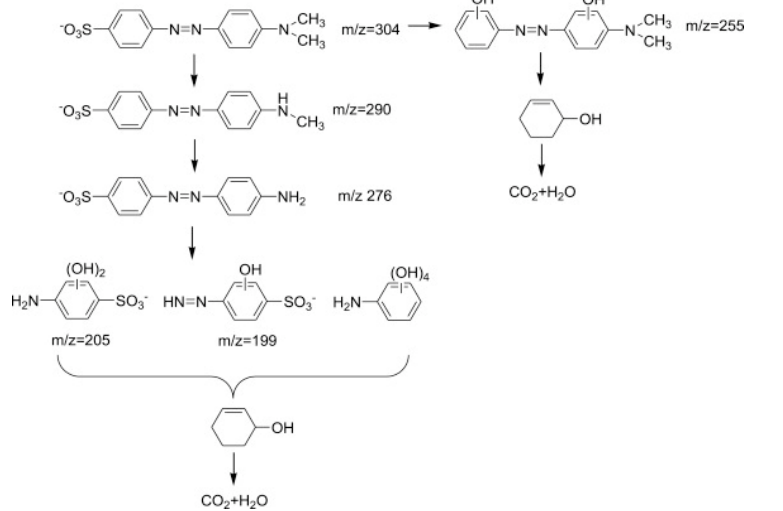
Scheme 1. Schemes follow the same